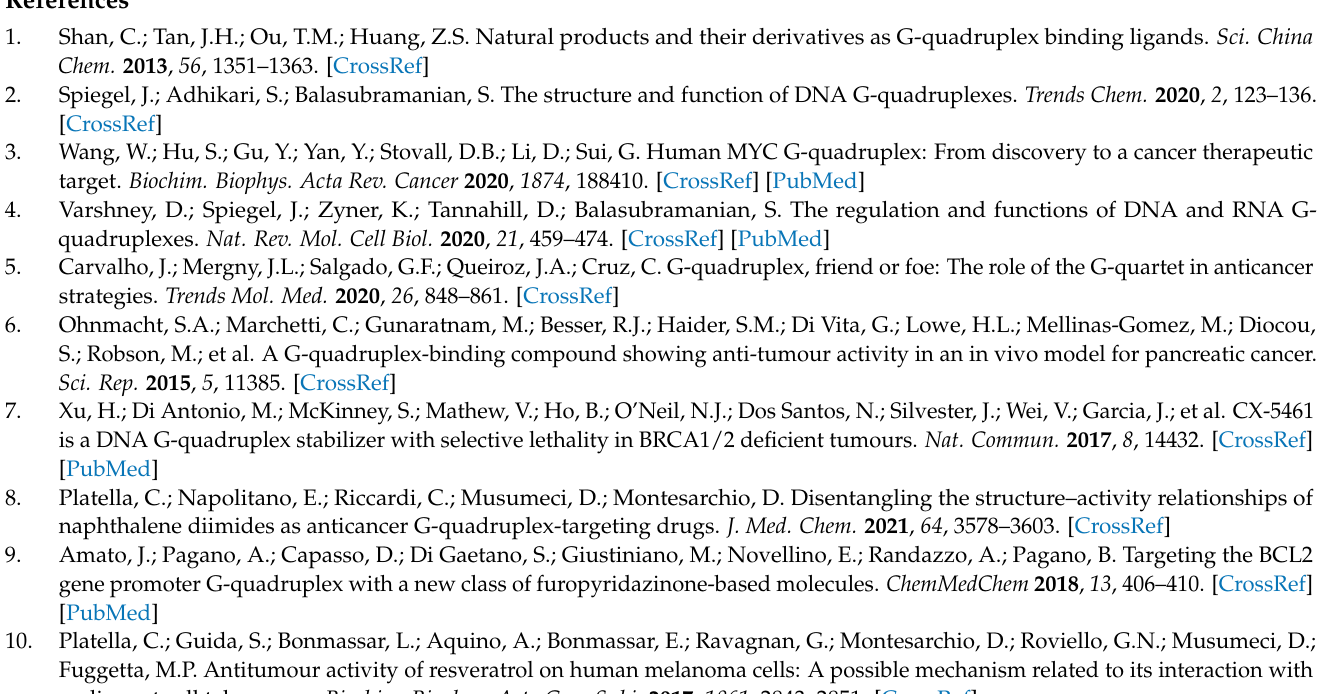
on increasing DNA concentration. Right: Representative binding curves obtained by plotting the fraction of bound Bulbocapnine to (D) tel 26 G4, (E) c-myc G4 and (F) ds 27 duplex as a function of the DNA concentration. The black squares represent the experimental data; the red lines represent the best fit obtained using an independent and equivalent-sites model, Figure S11: Left: Fluorescence emission spectra obtained by adding increasing amounts of (A) tel 26 G4, (B) c-myc G4 and (C) ds 27 duplex to 2 µ M solutions of Chelidonine. Arrows indicate the variation of fluorescence intensity on increasing DNA concentration. Right: Fluorescence intensity at 330 nm vs. concentration of (D) tel 26 G4, (E) c-myc G4 and (F) ds 27 duplex, Figure S12: Left: Fluorescence emission spectra obtained by adding increasing amounts of (A) tel 26 G4, (B) c-myc G4 and (C) ds 27 duplex to 2 µ M solutions of Ibogaine. Arrows indicate the variation of fluorescence intensity on increasing DNA concentration. Right: Representative binding curves obtained by plotting the fraction of bound Ibogaine to (D) tel 26 G4, (E) c-myc G4 and (F) ds 27 duplex as a function of the DNA concentration. The black squares represent the experimental data; the red lines represent the best fit obtained using an independent and equivalent-sites